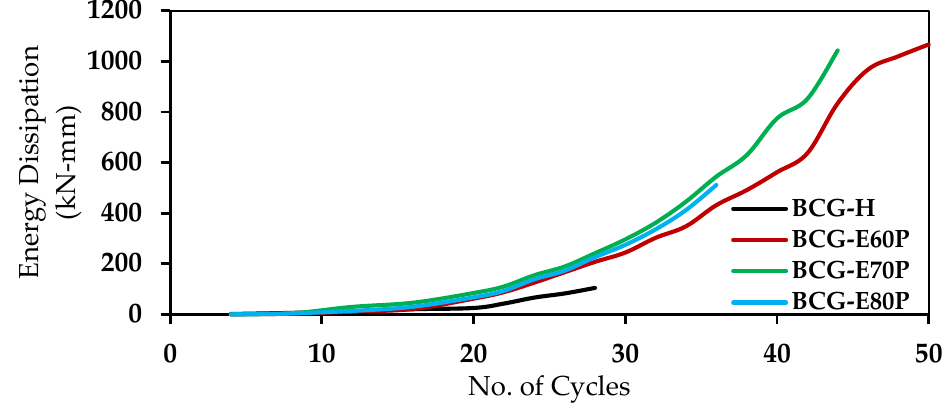
Figure 14. Energy dissipation curves.